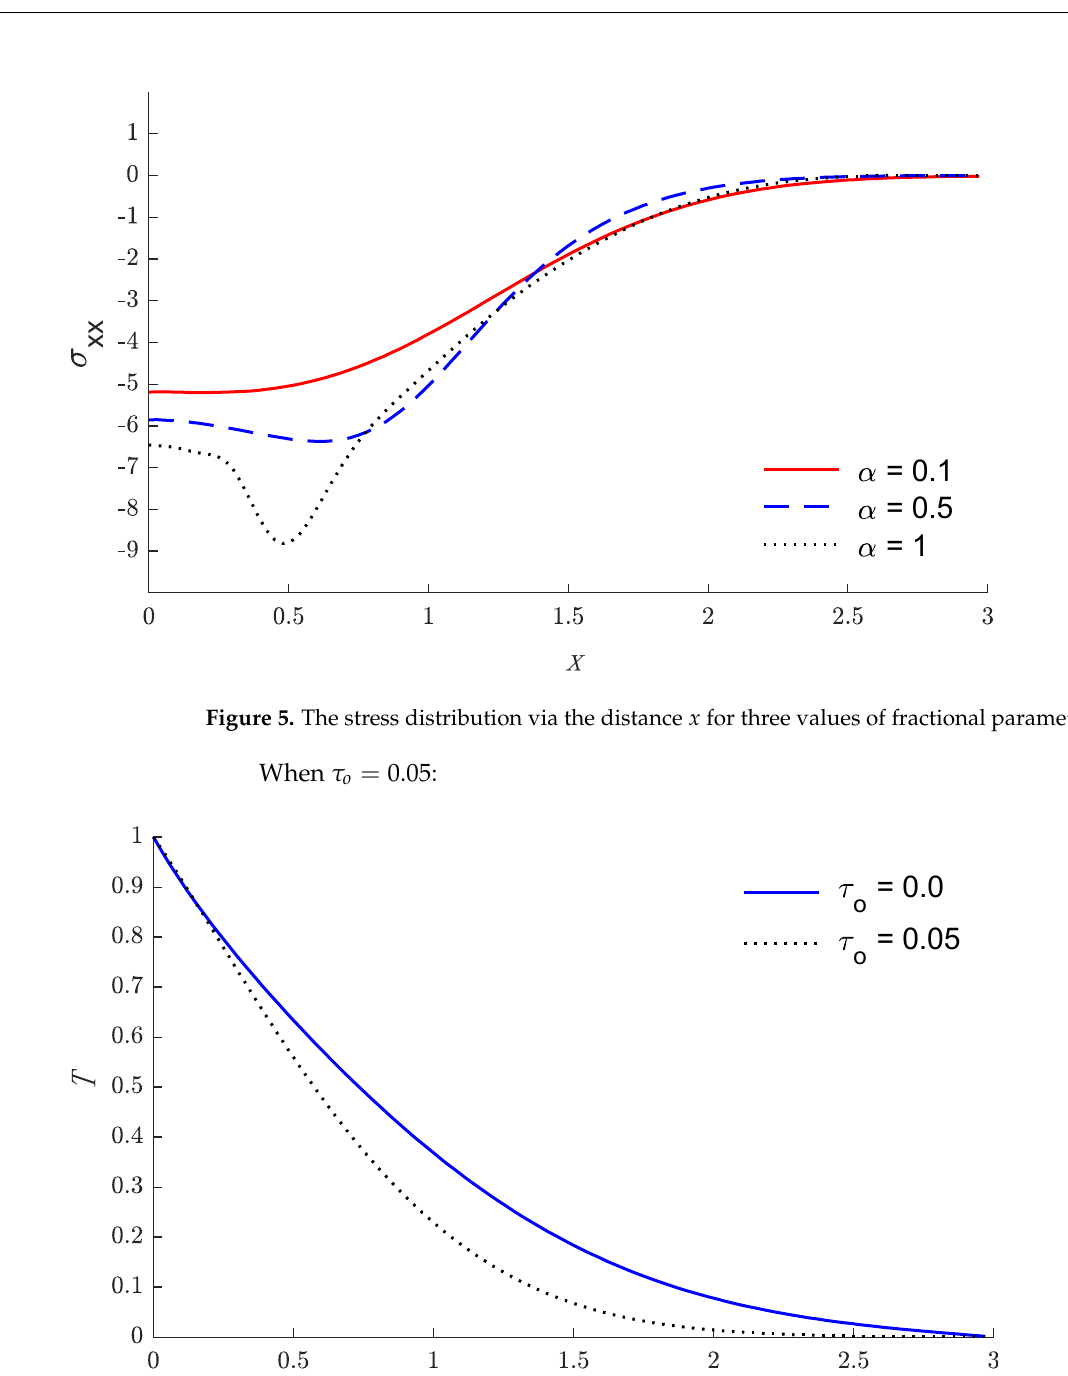
Figure 4. The electric field distributions via the distance 𝑥 for three values of fractional parame- ters. When 𝜏 (cid:3042) = 0.05 :